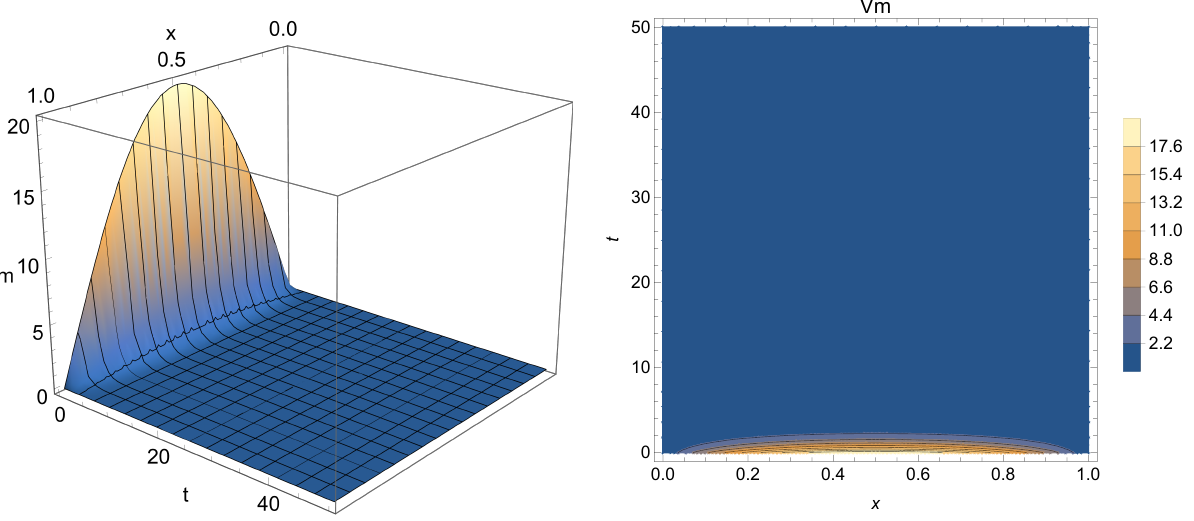
Figure 2. One-dimensional homogeneous solution describing the potential plateau after depolariza- tion: Equation (10) with α = 1.